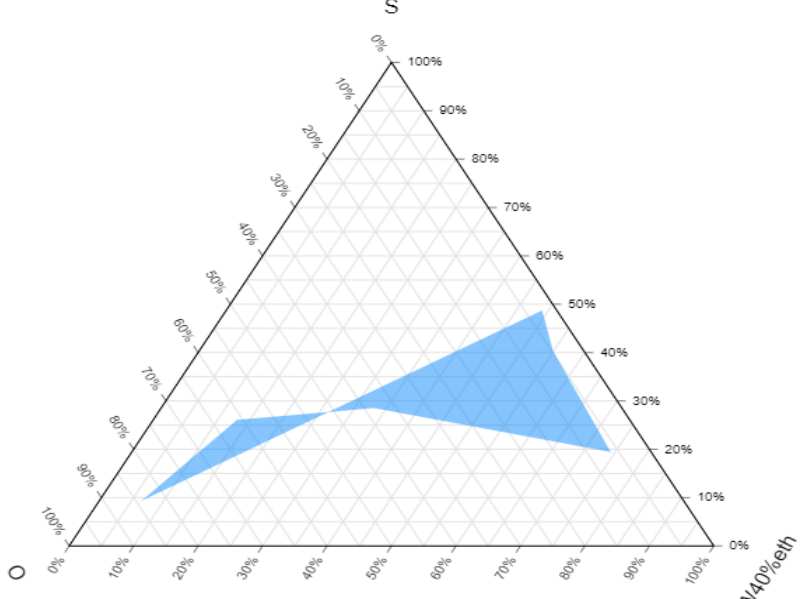
Figure 2. Ternary phase diagram of microemulsion composed of oil (O), surfactant (S), and aqueous phase (W, ethanol (40%)). Table 5. Characterization of placebo and active microemulsions.